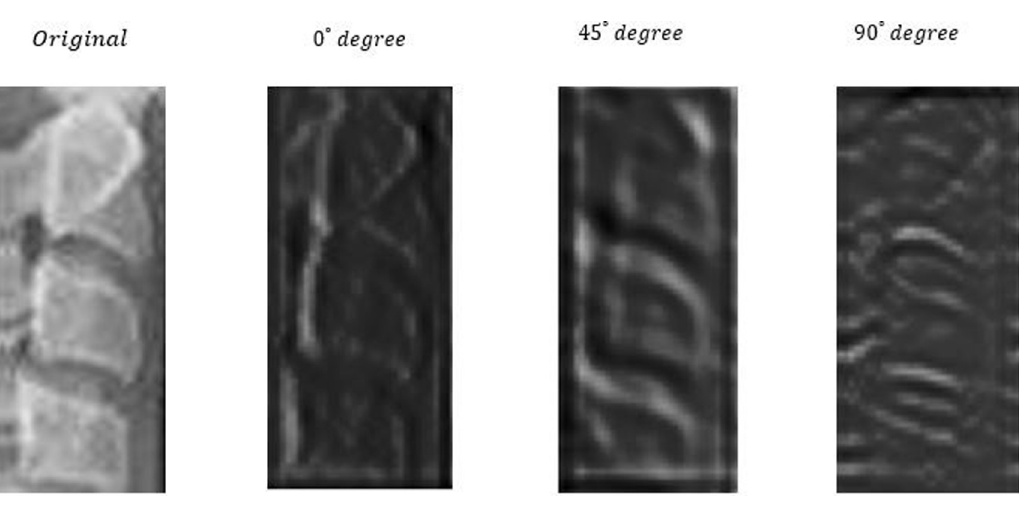
PLOS ONE | https://doi.org/10.1371/journal.pone.0269198 July 1,